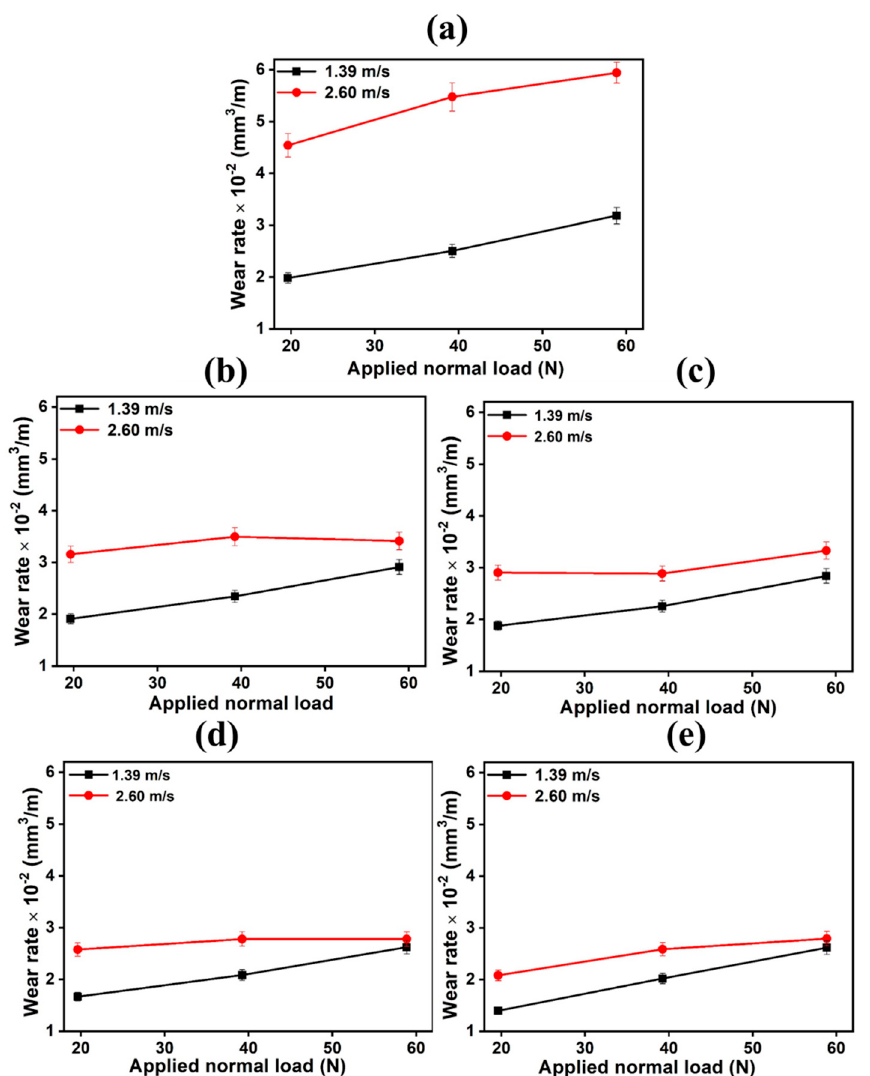
Figure 5. Variation of wear loss at different velocity and applied normal load for composites reinforced with SiC at ( a ) 0%; ( b ) 3%; ( c ) 6%; ( d ) 9%; ( e ) 12%. The optical micrograph of composites at a different percentage of SiC p was shown in Figure 6. The distribution of SiC p in AZ91 magnesium alloy seems to be reasonably uniform, but in some places, particles’ accumulations were observed. The primary magnesium dendrites ( α phase) which are coexisting with dark inter dendrite precipitate of intermetallic β phase. The dark blue arrows in Figure 6 represents α and the β phases are represented by saffron arrows. The β phase generally has the composition of Mg 17 (Al, Zn) 12 . The reinforced particles are represented by light blue arrows.